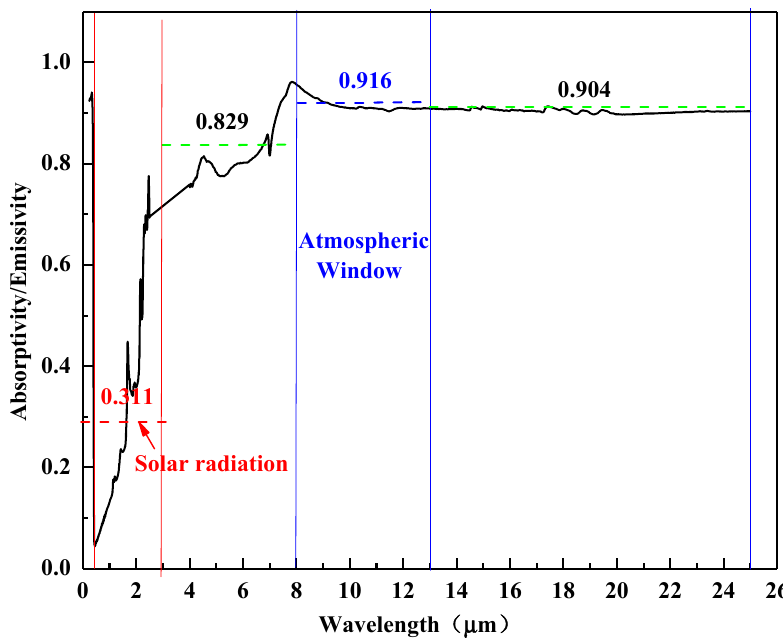
Figure 6. Variation of the measured radiator emissivity/absorptivity with wavelength.